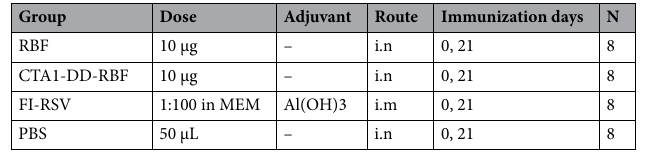
Table 1. Animal grouping and